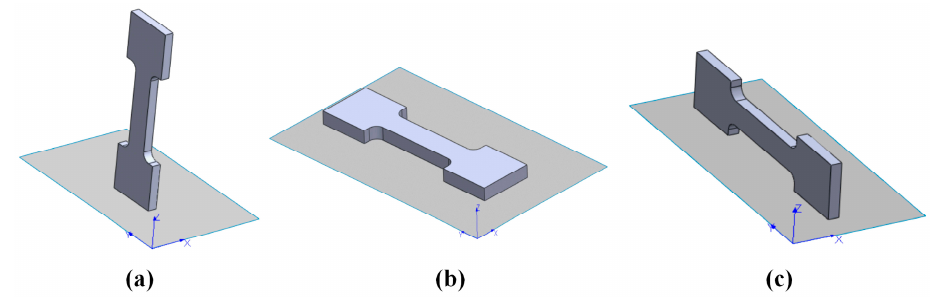
Figure 5. Examples of building orientations: ( a ) main direction parallel to the xz -plane; ( b ) main direction parallel to the xy -plane; and ( c ) main direction parallel to the zx -plane. The z axis in the picture indicates the building direction, while the x and y axes identify the building platform plane.